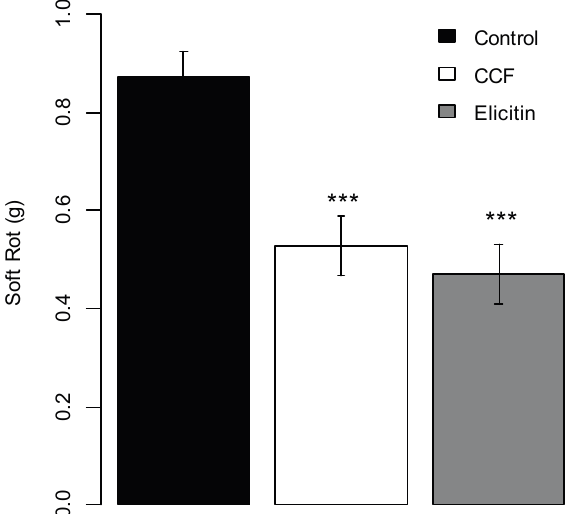
Figure 7. Protection effect of partially purified elicitin (400 µg/slice) on potato tubers slices against Pectobacterium atrosepticum . Values are means of replicates of one experiment with two blocks ± standard errors. Bars with different stars subscripts